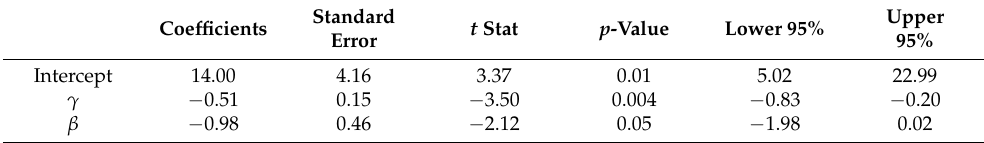
Table 10. Coefficient regression